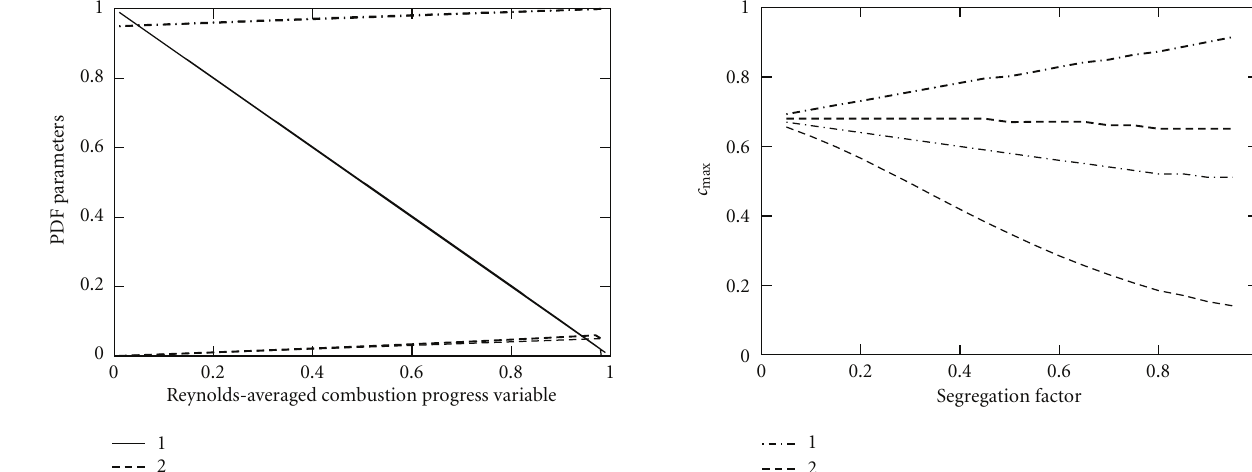
w ( c )-curve using